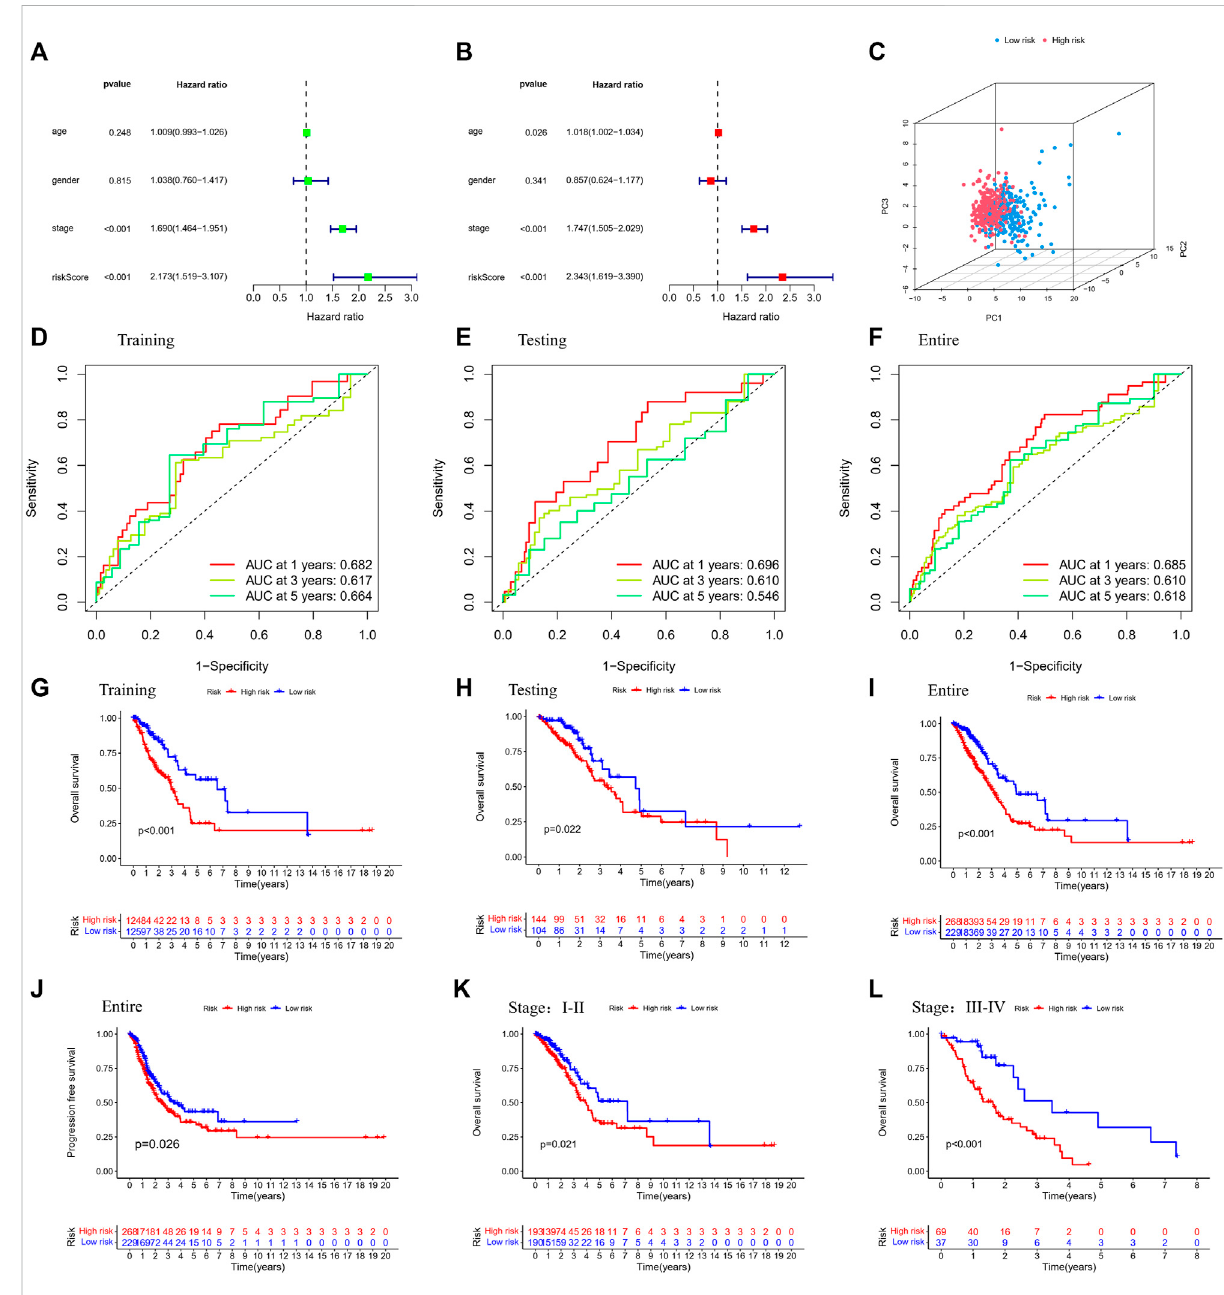
FIGURE 4 Validation of the prognostic strati fi cation model. (A) Univariate analysis for the entire dataset. (B) Multivariate analysis for the entire dataset. (C) PCA plot for LUAD in the entire dataset. (D – F) Time-dependent ROC curves for LUAD in the training, testing, and entire datasets. (G – I) K-M survival analysis of different risk groups in the training, testing, and entire datasets. (J) PFS of the entire dataset. (K,L) K-M survival analysis of patients with different stages in low- and high-risk groups. (Chi-squared